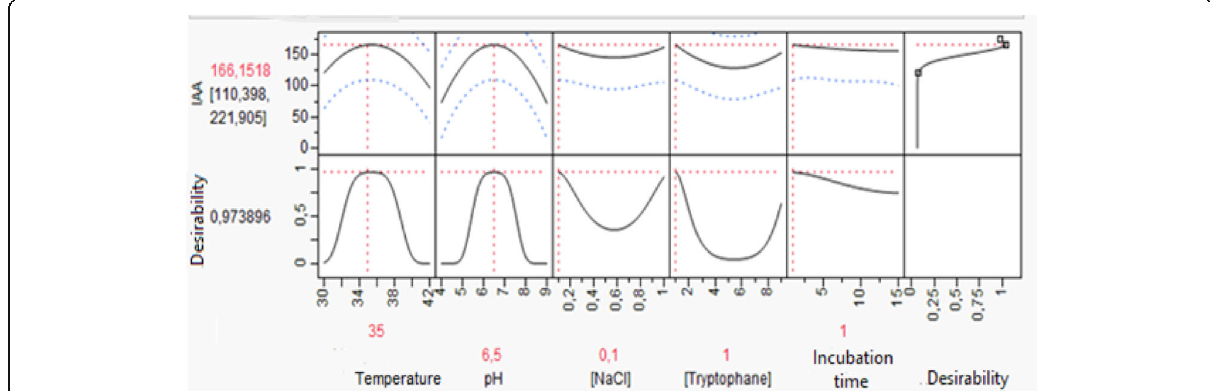
Fig. 5 Desirability plot showing the precise operating conditions leading to the optimal yield of IAA